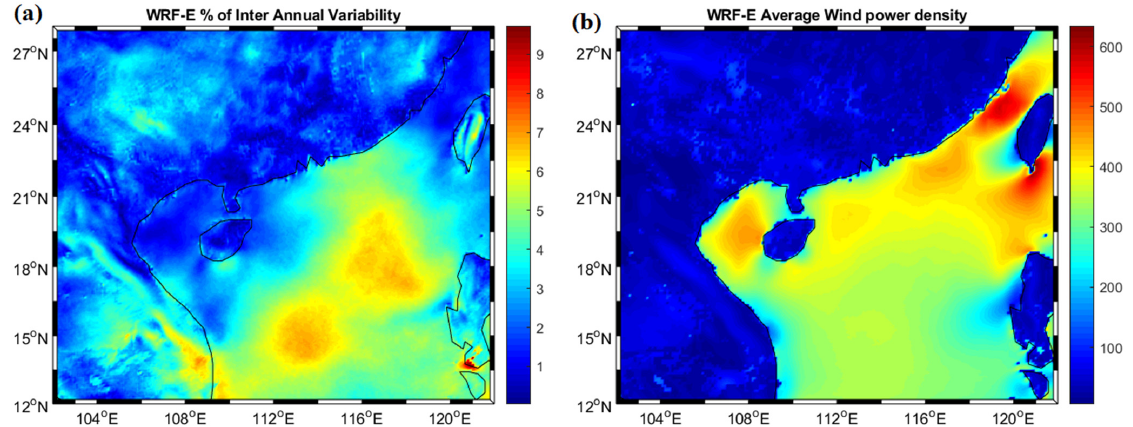
Figure 11. (a) Interannual variability and ( b ) average wind power density (m 3 s − 3 ) for the year 2015– 2018 from WRF-E